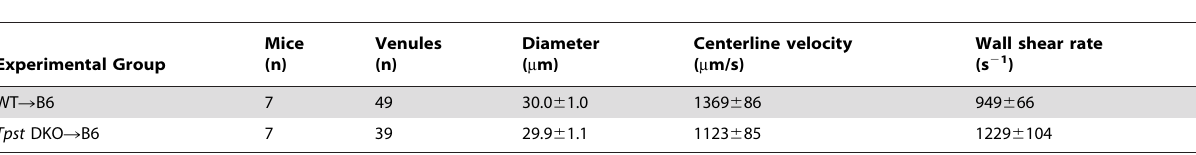
Table 2. Hemodynamic and microvascular parameters.